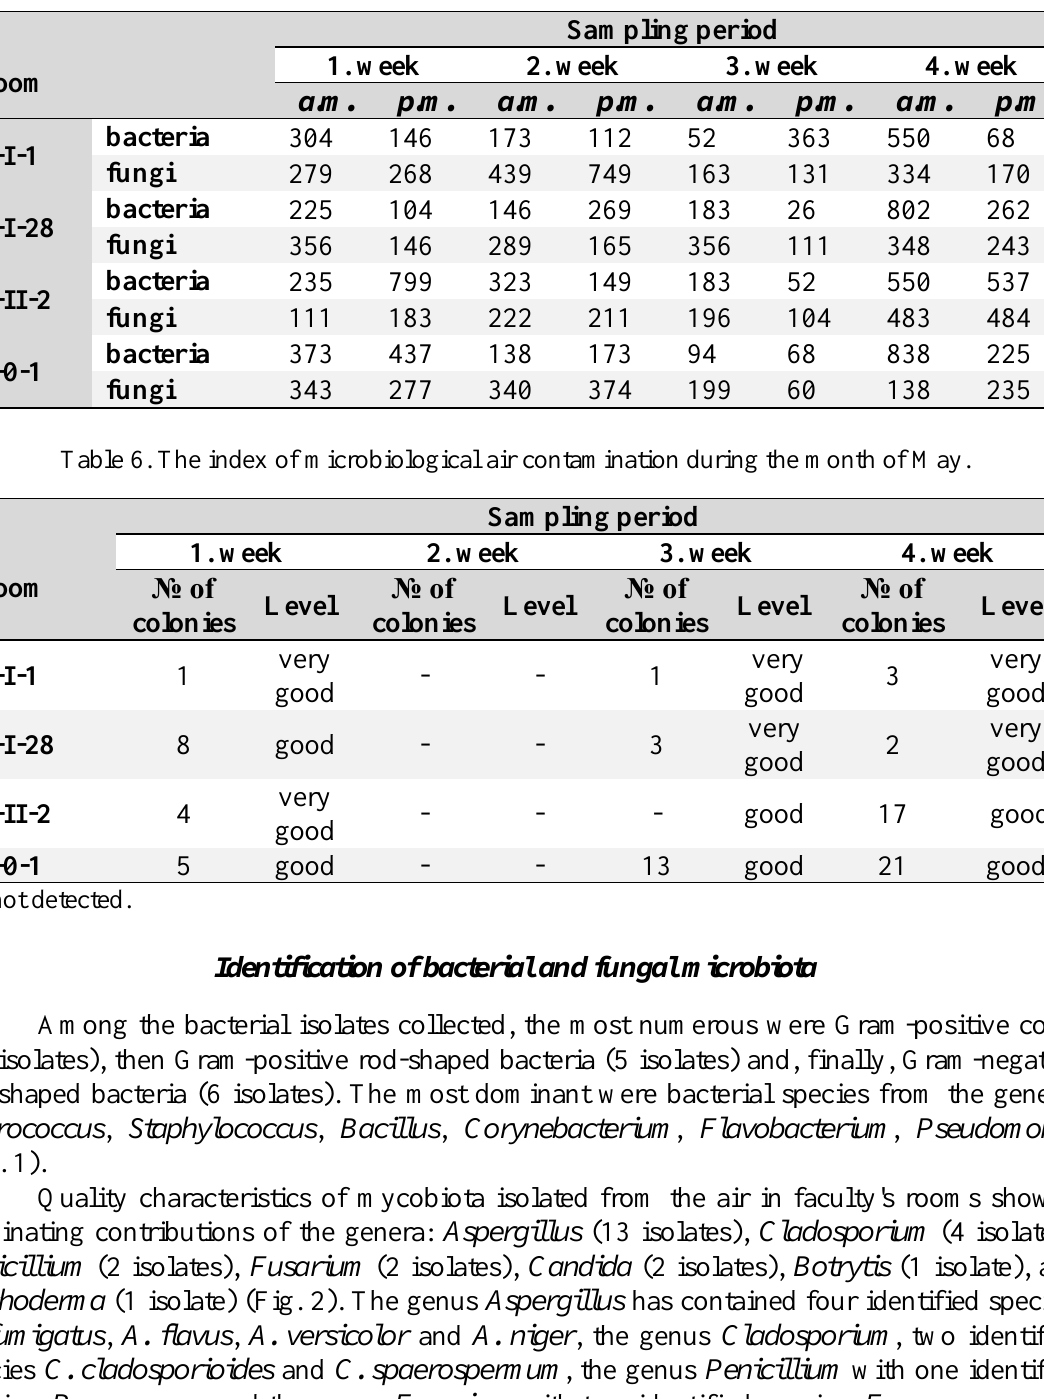
Table 5. The total number of bacteria/fungi (cfu/m 3 ) in indoor air in faculty's room during the month of May.